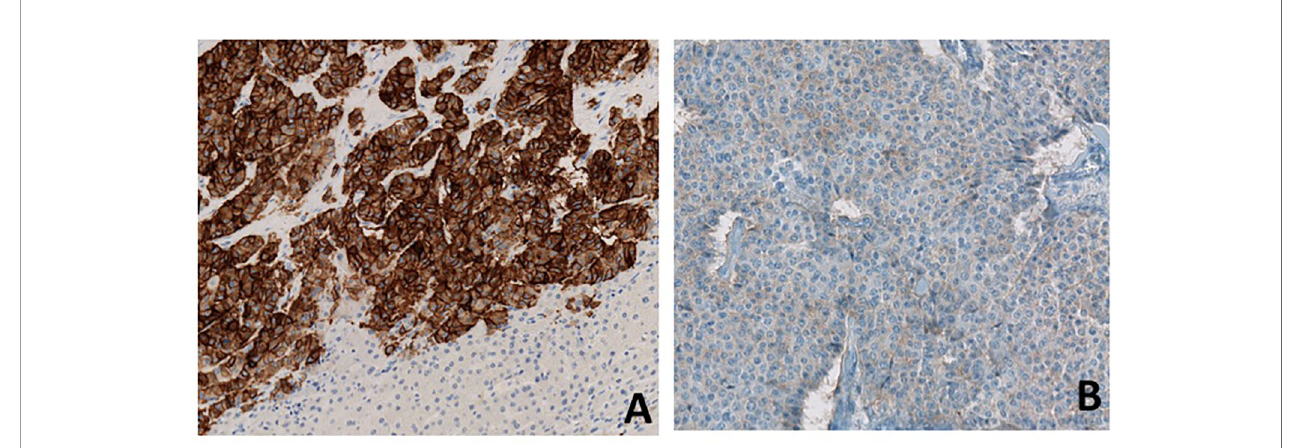
FIGURE 2 | Immunostaining for SSTR2 (A) and SSTR5 (B) . Immunostaining of metastatic hepatic lesion shows high expression of SSTR2 and low expression of